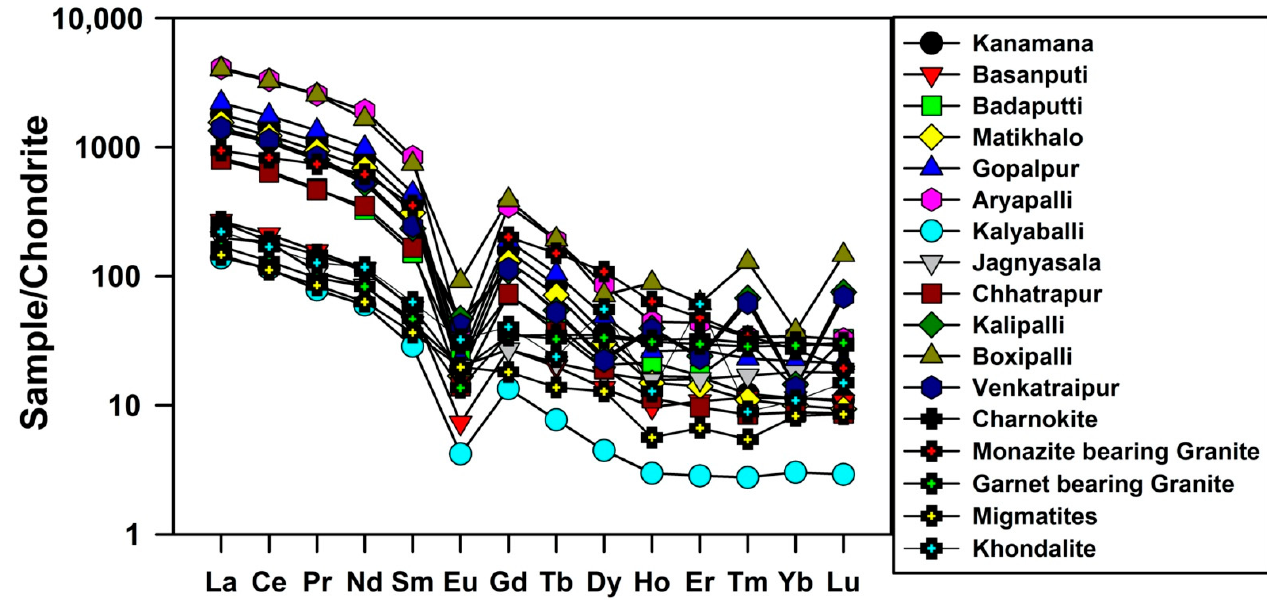
Figure 1. Chondrite normalized REE patterns of soils and hinterland rocks. The europium ( Eu A ) anomaly of the samples was estimated as follows: Eu N √ Eu A = Sm N × Gd N here, Sm N and Gd N are the concentrations of samarium and gadolinium of the bulk soils normalized with respect to the chondrite